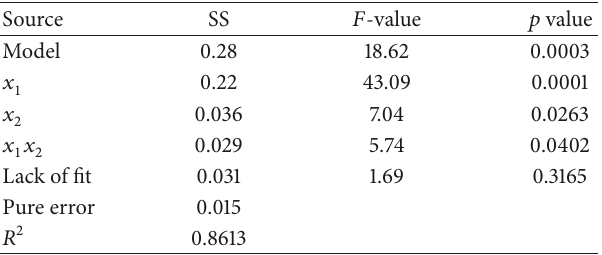
Table 6: ANOVA evaluation for synthetic evaluation index ( 𝑆 ) and coefficient of prediction